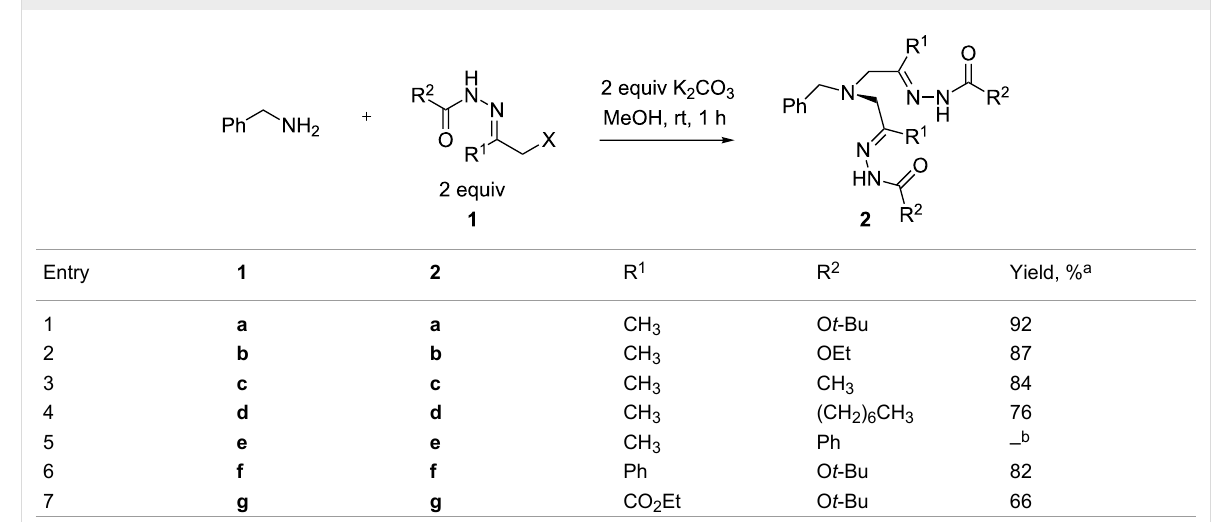
Table 1: Reaction of α -halogen-substituted hydrazones 1 with